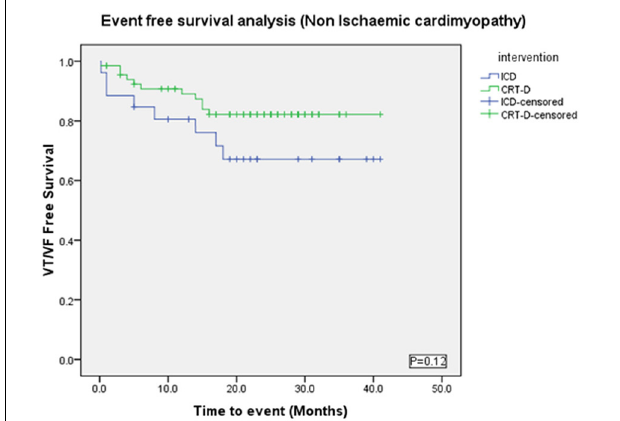
Table 2 | Ischemic cardiomyopathy—Patient characteristics.